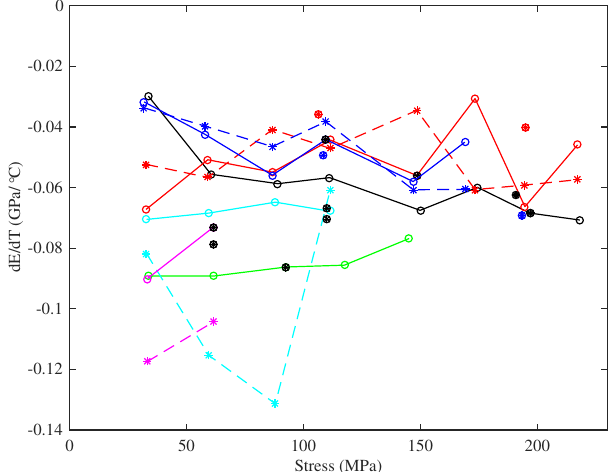
Figure 18. The rates of thermal variation in Young’s modulus, about the base temperature of 20 ◦ C, plotted against the applied stress. The solid lines show the results obtained using tension modulation, while the dashed lines provide a comparison with the values derived from the string bending sti ff ness. The latter data were only available for the last four strings tested, after the harmonic analysis capability had been added into the test rig control program. Colours identify the di ff erent tested strings (Table 1): black (8:A6), red (14:A5), blue (5:A4), green (23a:A3), cyan (29:E3), magenta (10b:A2). Black circles show the results at the expected operating points for the Bowbrand strings tested at the usual humidity levels (around 55–65% RH at 20 ◦ C); blue circles show Pirastro strings; red circles show tests at low humidity (around 20–26% RH at 20 ◦